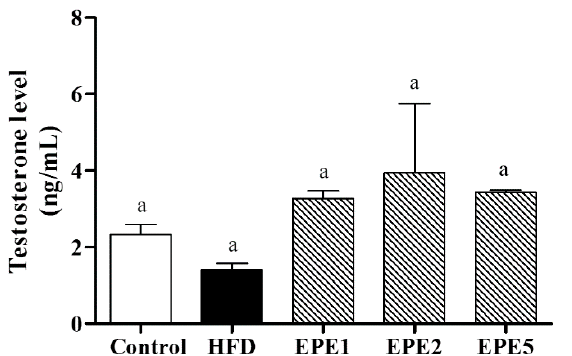
Figure 3. Effects of Echinacea purpurea ethanol extract in the plasma testosterone level in HFD-induced obese rats after 5 weeks. Data are shown as the mean ± S.E.M. ( n = 5). The values with different superscript letters (a) are significantly different ( p < 0.05), as determined via one-way ANOVA, and were analyzed by Duncan’s multiple range